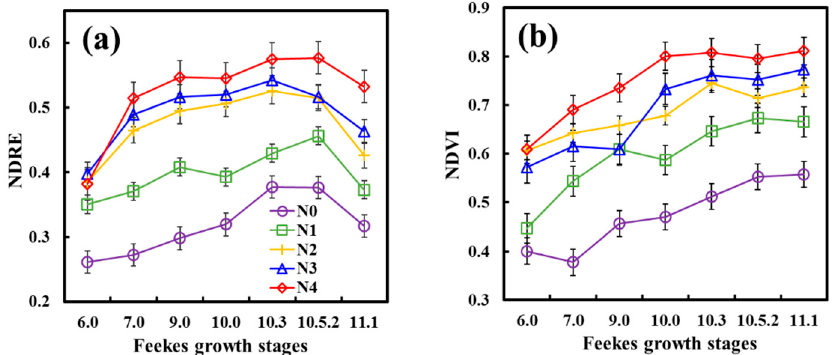
Figure 3. Dynamic variation in the ( a ) normalized difference red edge (NDRE) index and ( b ) normalized difference vegetation index (NDVI) with Feekes growth stages. Data were collected from Experiment 1 using the Huaimai20 variety. Vertical bars at each sampling date represent the standard error.